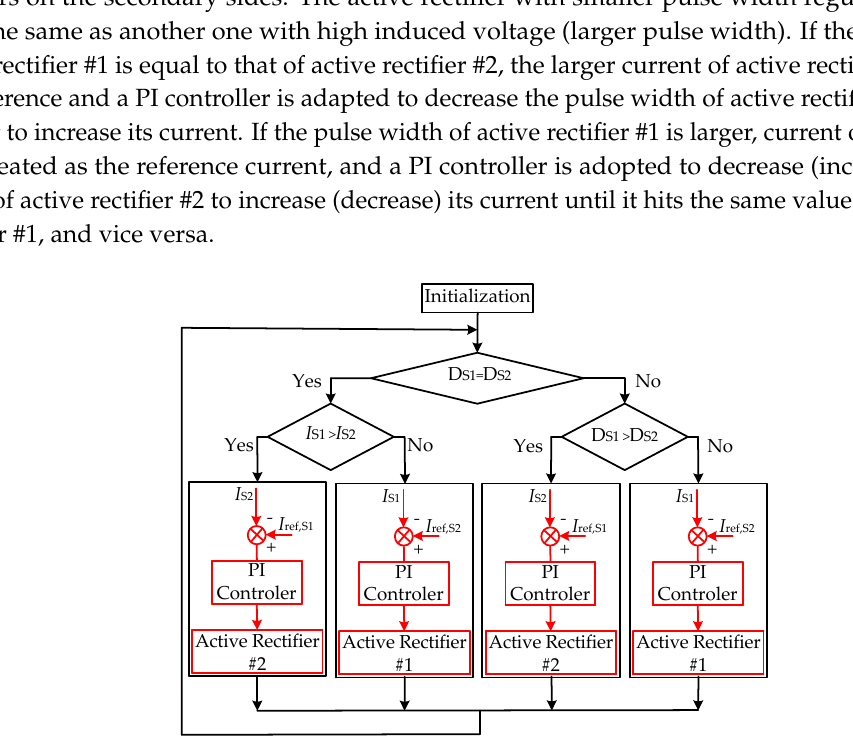
Figure 7. Control scheme of the proposed method.